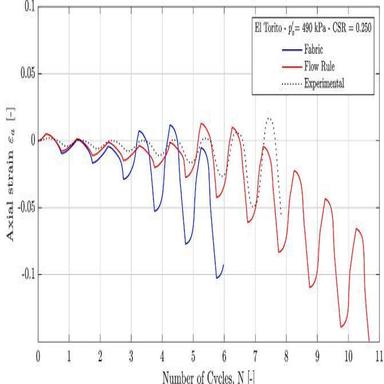
Axial strains development for the El Torito tailings sand.